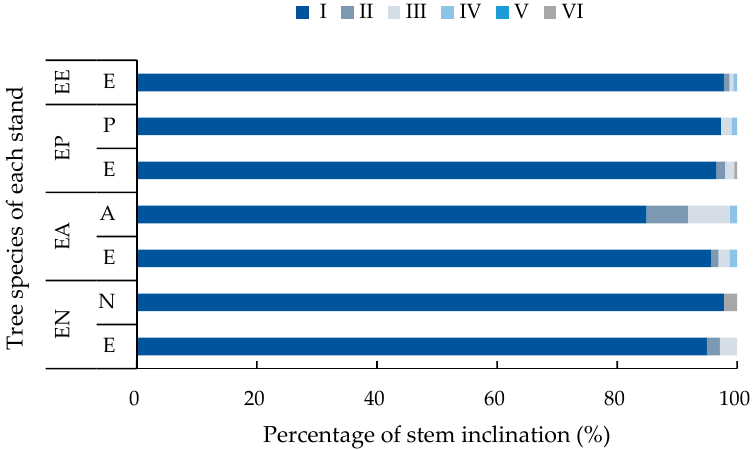
Figure 7. Degree of stem inclination of different tree species among pure and mixed forests of Eucalyptus . Length of different colors shows the percentage of different grades of stem inclination. EN: mixed plantation of Eucalyptus (E) and N. cadamba (N); EA: mixed plantation of Eucalyptus (E) and A. mangium (A); EP: mixed plantation of Eucalyptus (E) and P. elliottii × P. caribaea (P); EE: pure forest of E. urophylla × E. grandis . Table 7. Degree of the inclination of tree stems among pure and mixed forests of Eucalyptus . Stand Type